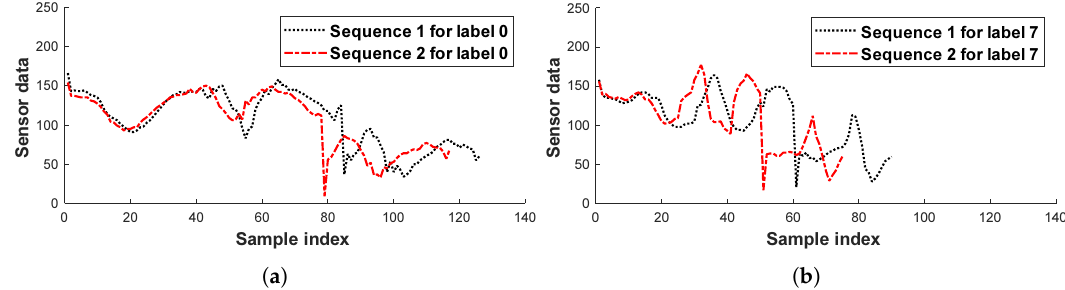
Figure 5. Examples of the data sequences: ( a ) two sequences for label 0; ( b ) two sequences for label